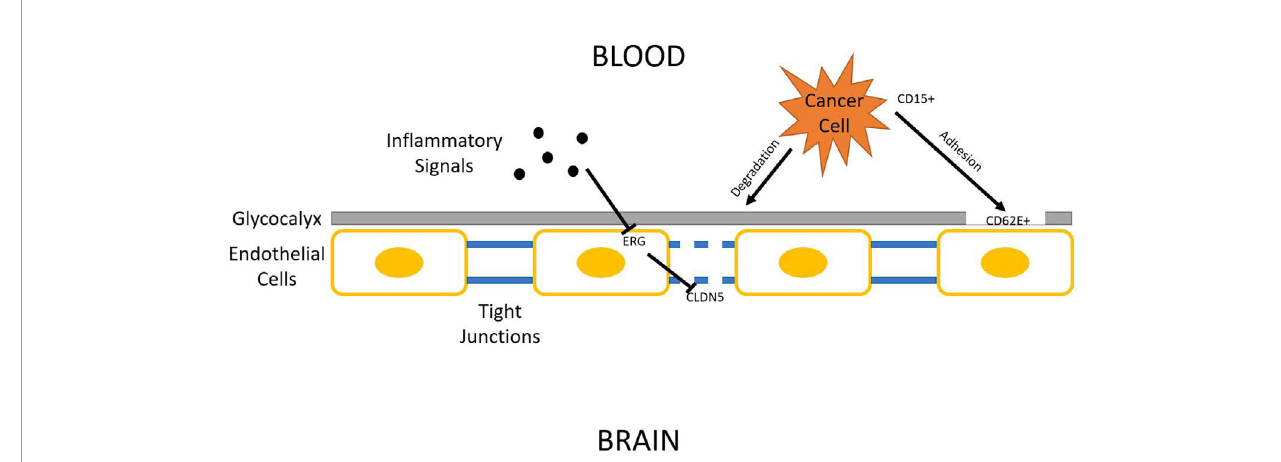
FIGURE 2 | Blood – brain barrier (BBB) penetration. Lung cancer cells must breach BBB in order to access the brain parenchyma. The three general steps shown in this fi gure are glycocalyx degradation, epithelial adhesion, and tight junction